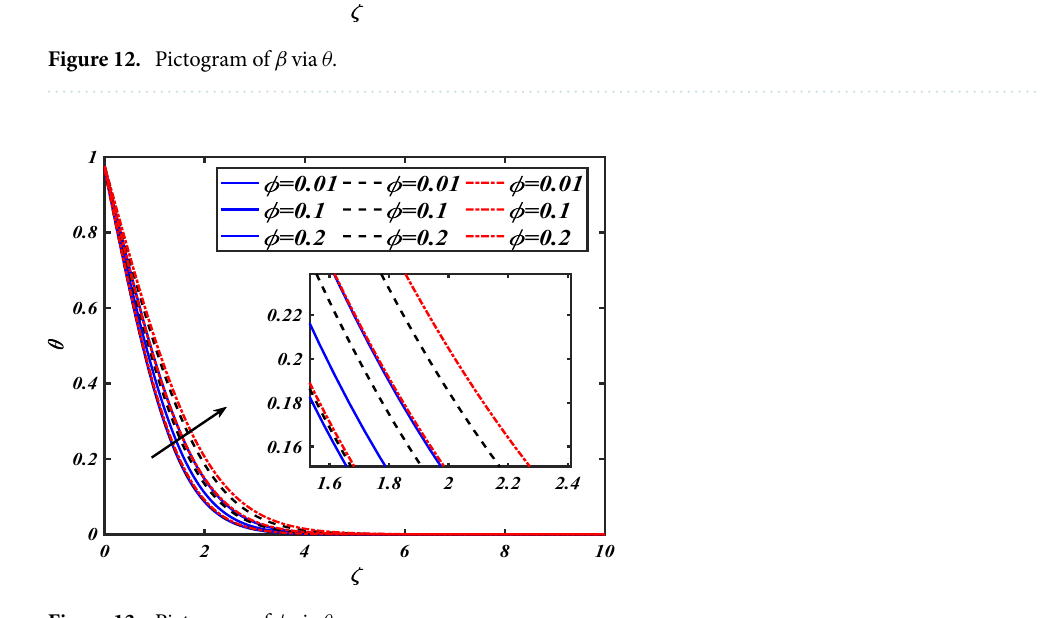
Figure 13. Pictogram of φ via θ